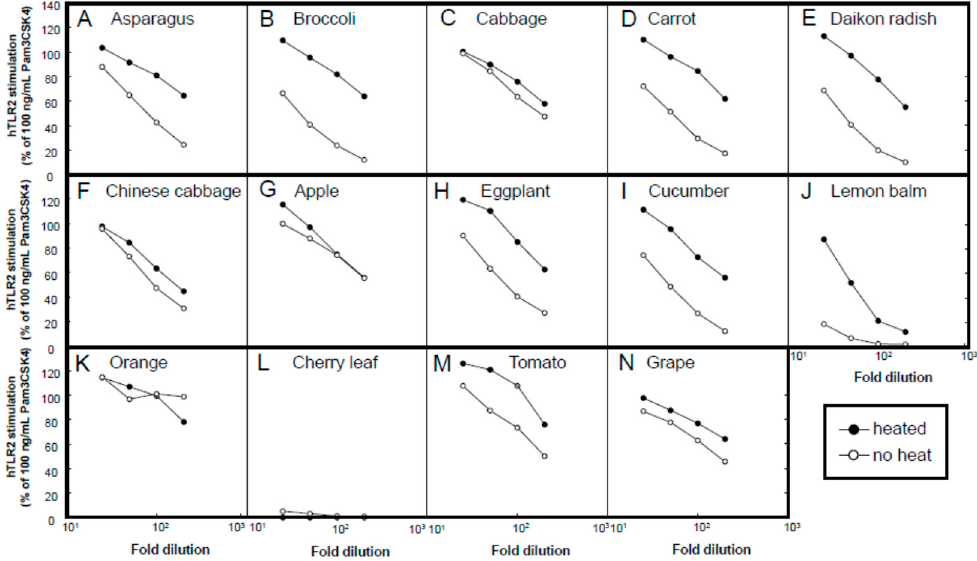
Figure 4. Comparison of different plant extracts used as the culture medium for TL24. ( A ) Asparagus (stem of edible part), ( B ) broccoli (stem of edible part), ( C ) cabbage (edible part), ( D ) carrot (edible part, root), ( E ) daikon radish (edible part, root), ( F ) Chinese cabbage (edible part), ( G ) apple (fruit), ( H ) eggplant (fruit), ( I ) cucumber (fruit), ( J ) lemon balm (leaf), ( K ) orange (fruit), ( L ) cherry leaf, ( M ) tomato (fruit), and ( N ) grape (fruit) were extracted with hot water, mixed with 3% cow skimmed milk, and used as culture media for TL24. Open and closed circles represent the TLR2-stimulating activities of the culture supernatants before and after heat treatment at 110 ° C for 20 min, respectively. (n = 1).